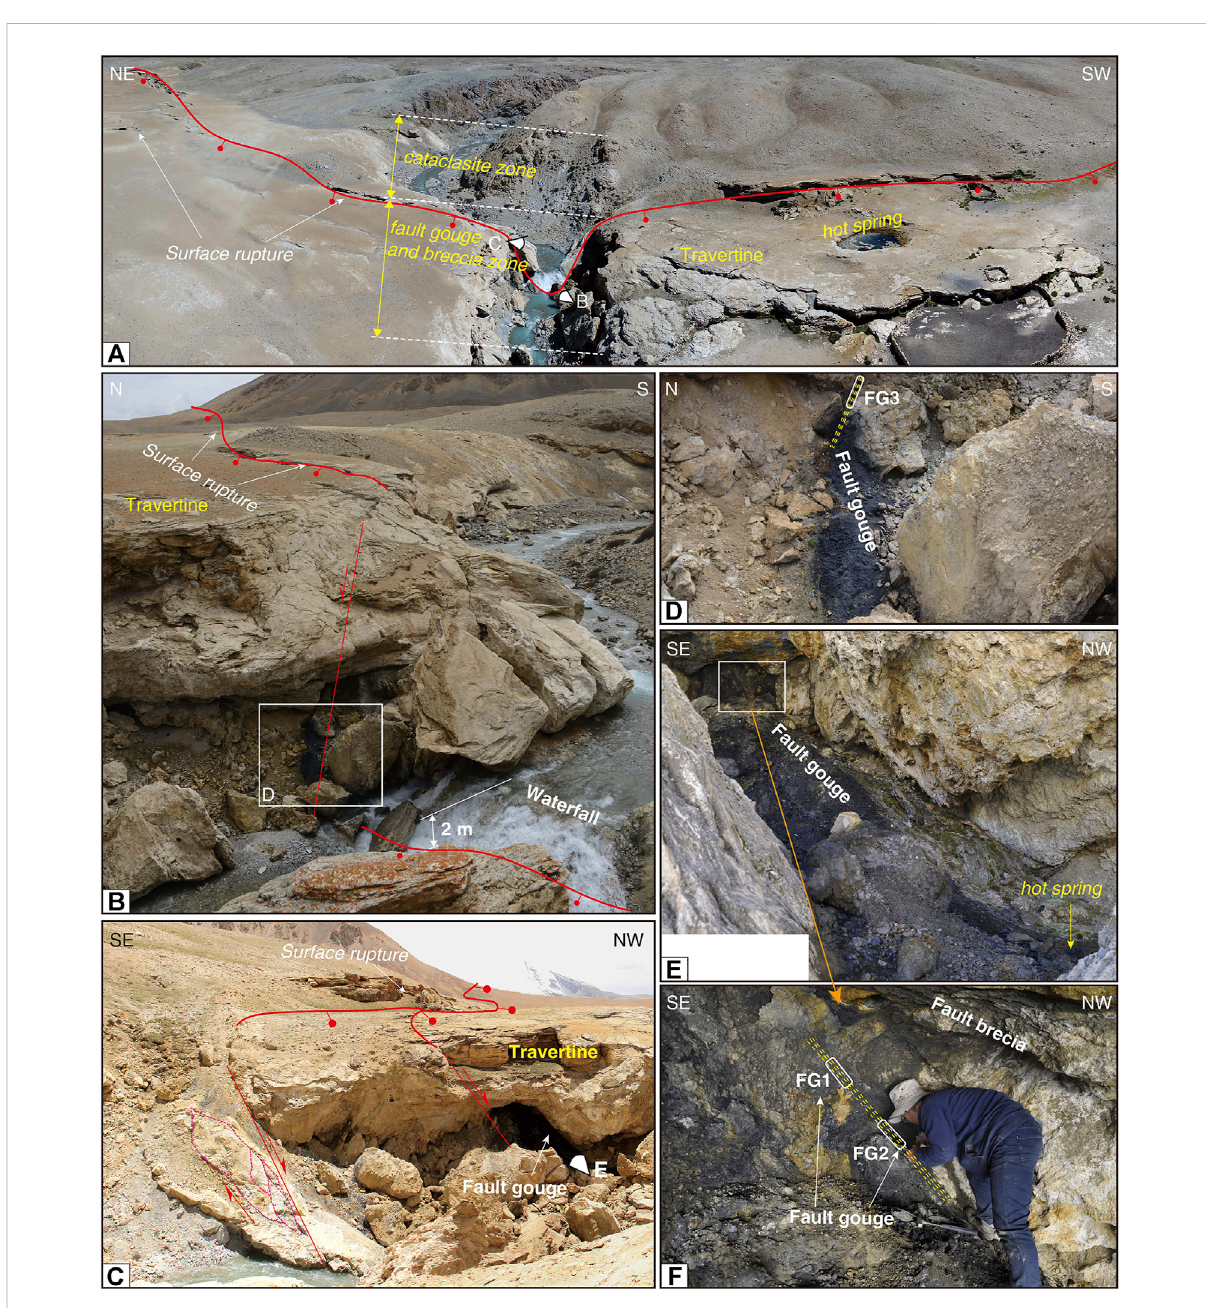
FIGURE 5 Field photos of active normal faults and location of fault gouge samples north of Chumba Yumco lake. (A) UAV photo of surface cracks in the travertine and fault rock distribution along active faults. (B,C) Exposure of fault gouge beneath the travertine as well as ~2 m-high waterfall due to normal throw. (D – F) Black fault gouge where three samples, FG1 – FG3, were collected for authigenic illite K-Ar age